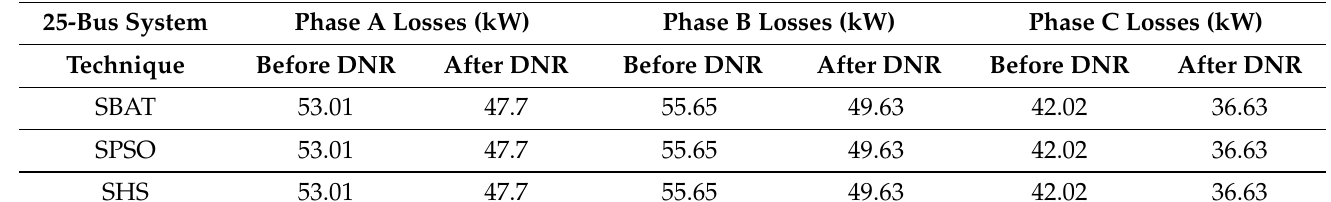
Table 13. Total losses per phase (25-bus system/fixed demand).